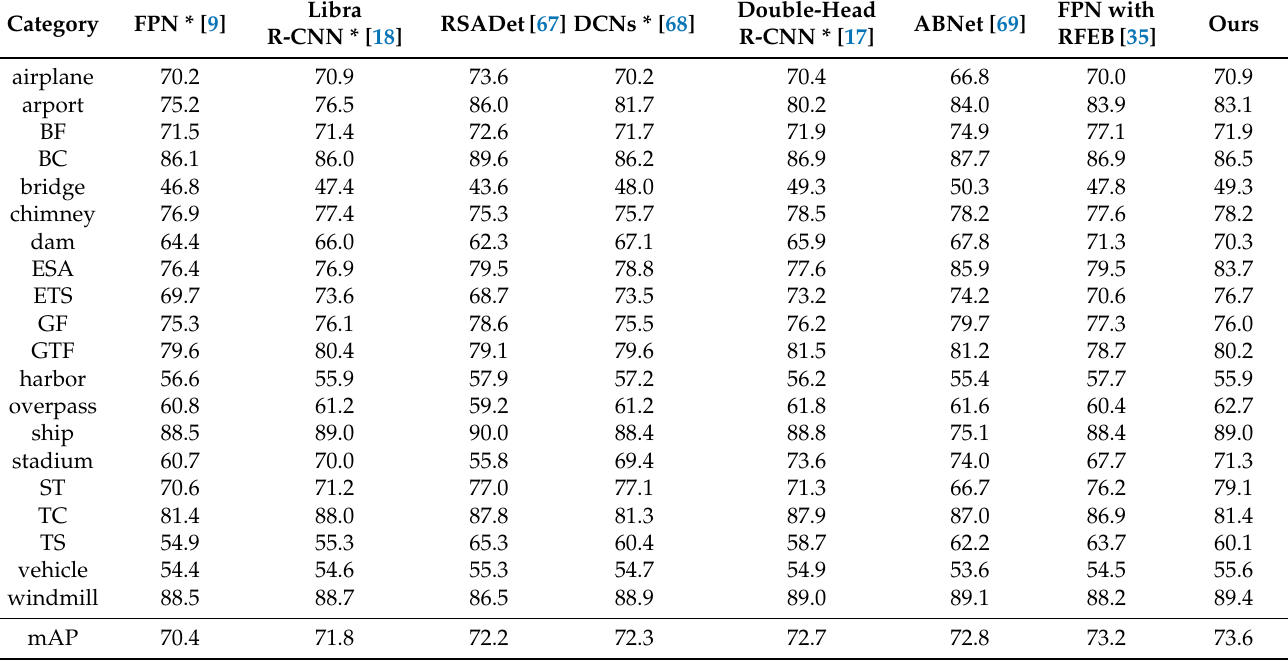
Table 4. Detection accuracy comparisons of different methods on the DIOR dataset. * indicates our